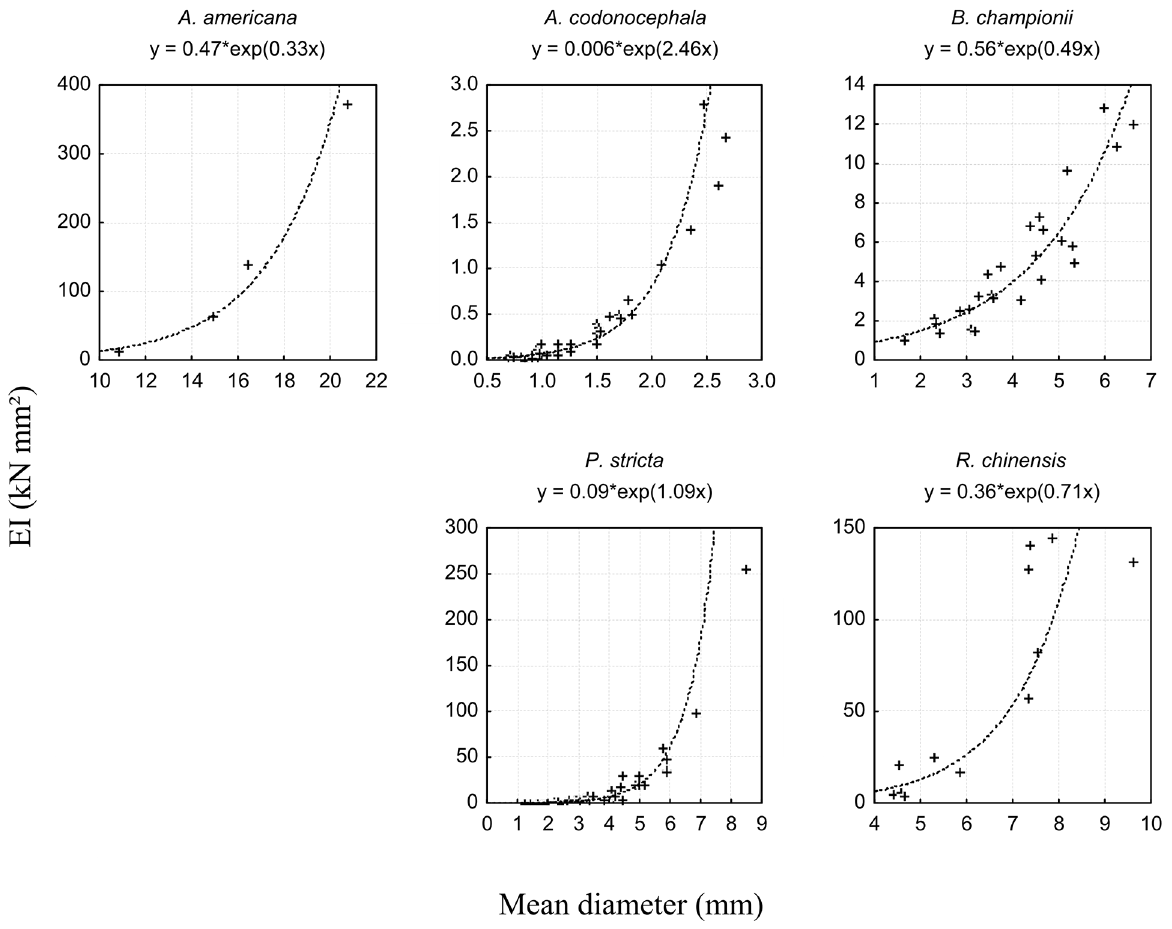
Figure 9. Bending rigidity. Bending rigidity ( EI ) as a function of root mean diameter for each species where data were sufficient for statistical analyses. Mean root diameter is the mean of depth and width diameters for each root. Note that scales differ between graphs for easier viewing.